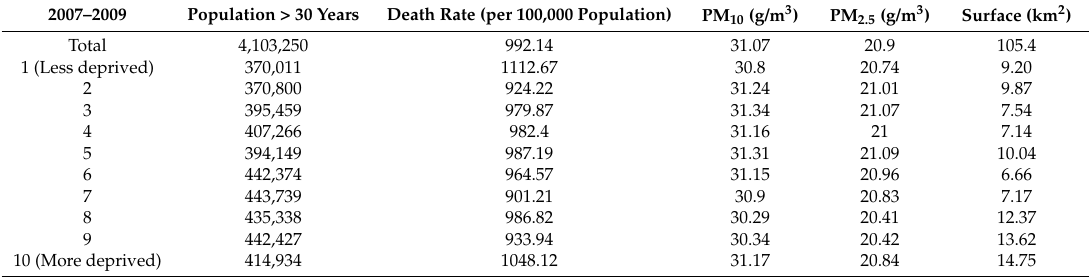
Table 2. Descriptive statistics by socioeconomic deprivation class over the period 2007–2009. It corresponds to the input data of the HIA for PM 10 and PM 2.5 exposure.